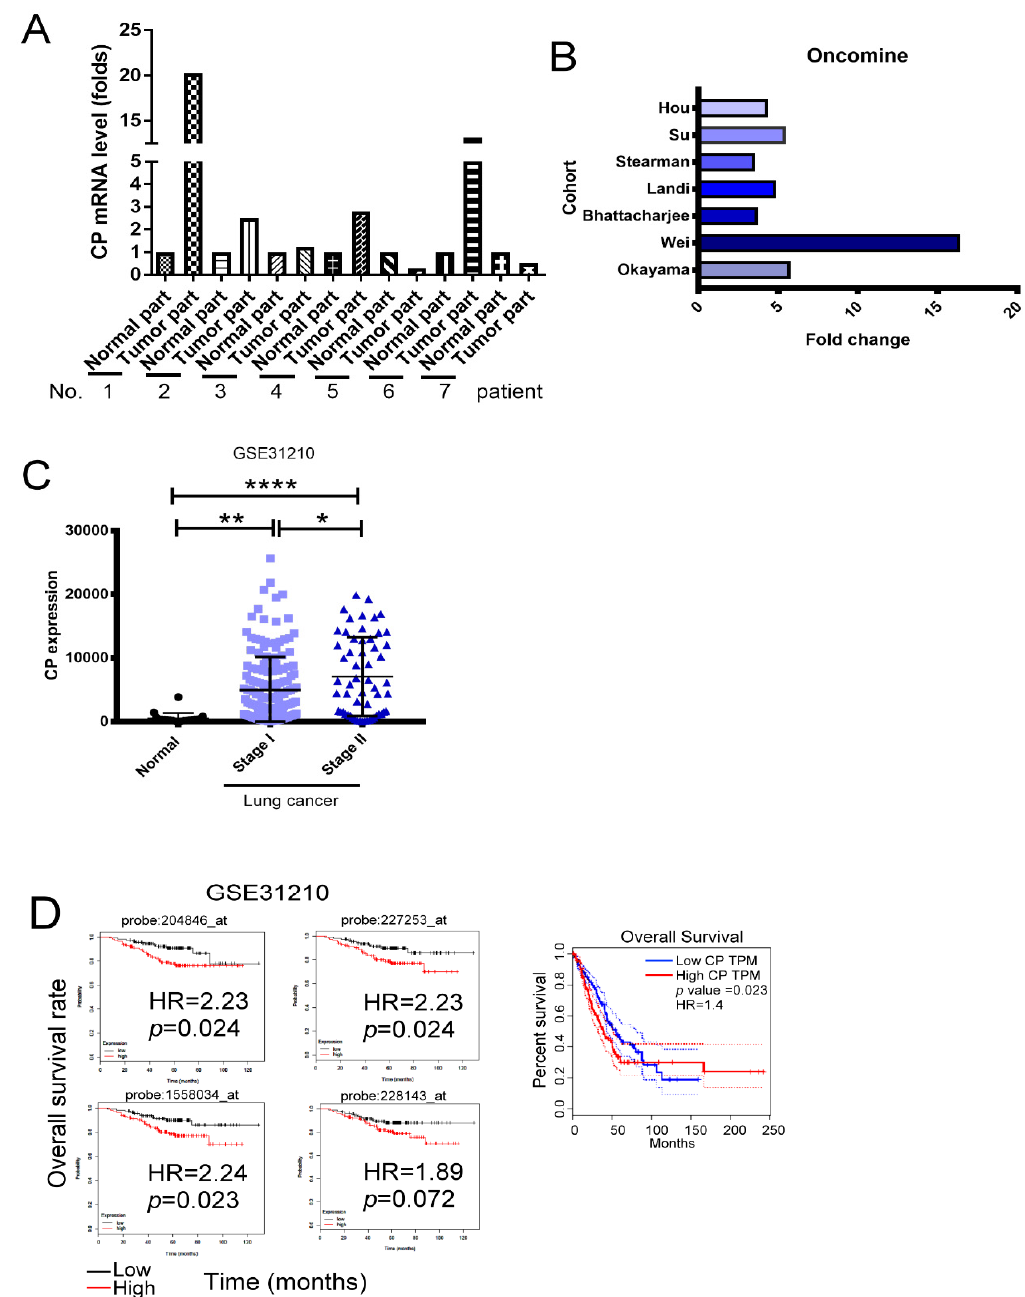
Figure 1. Ceruloplasmin (CP) protein is upregulated in lung cancer and correlated with poor overall survival rate. ( A ) Upregulated CP in the tumor of 7 lung cancer patients. ( B ) The elevated levels of CP in lung cancer patients are found from seven independent microarrays retrieved from the Oncomine ® database. ( C ) The level of CP in lung cancer patient (GSE31210, 20 normal, 168 stage I and 57 stage II lung cancer tissue). ( D ) The relationship of CP protein with the clinical outcome of lung cancer patients. * p < 0.05, ** p < 0.01, **** p < 0.0005.